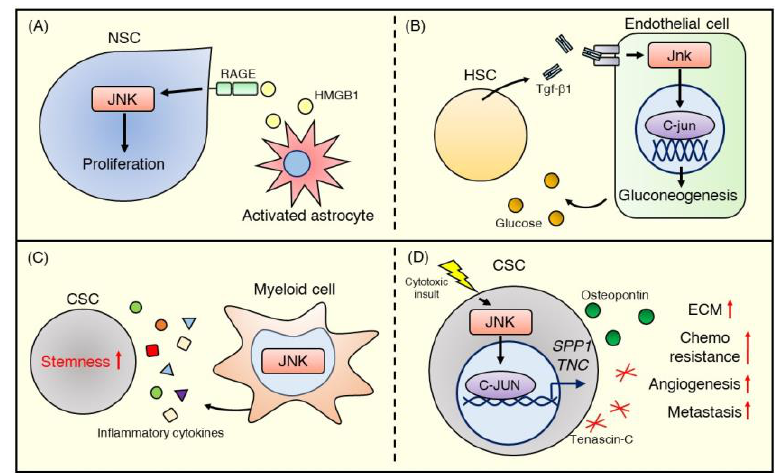
Figure 5. JNK signaling in the stem cell niche. ( a ) HMGB1 released from activated astrocytes stimulates the RAGE-JNK pathway and promotes the proliferation of NSCs. ( b ) Embryonic HSCs